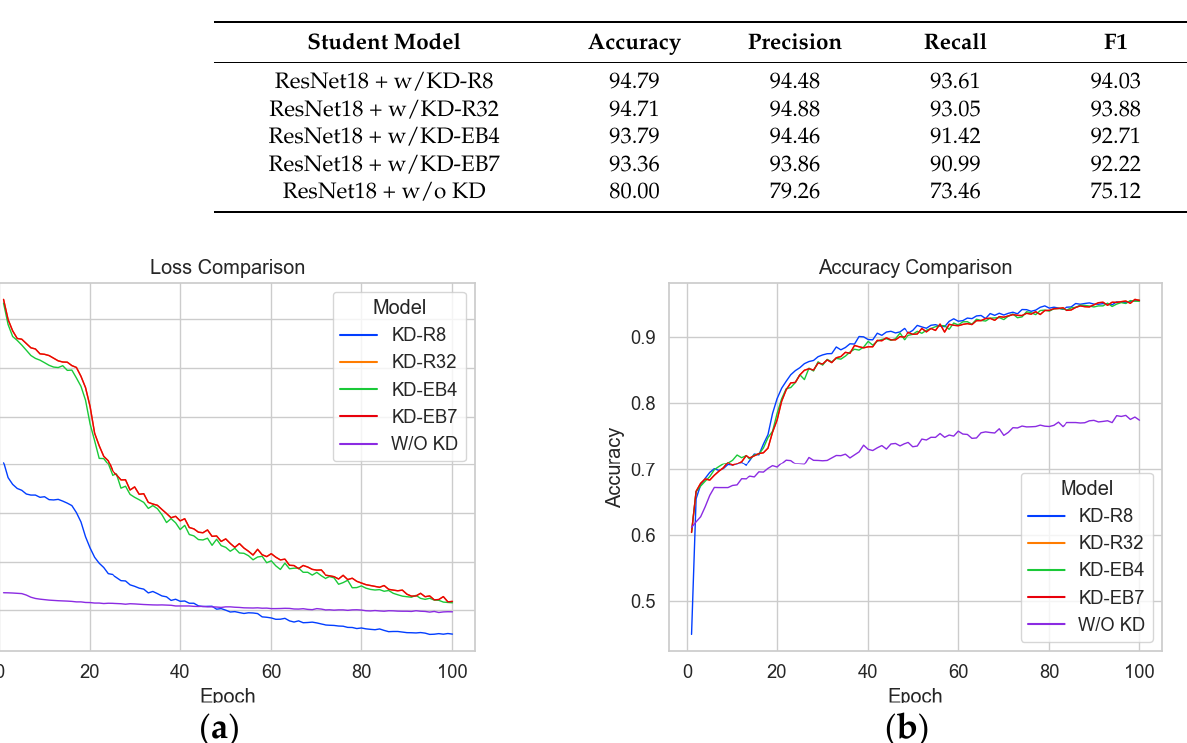
Table 6. Performance of the student models based on KD.